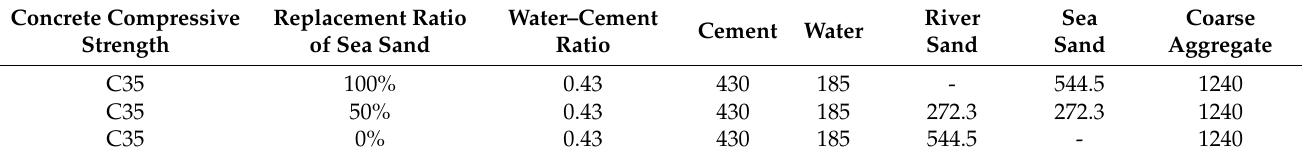
Table 2. Mix proportions of